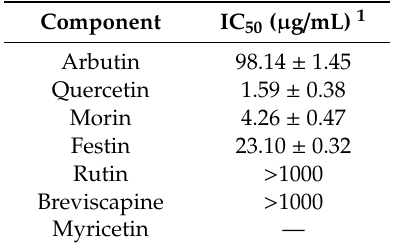
Table 1. Anti-tyrosinase activity of arbutin and flavonoids.